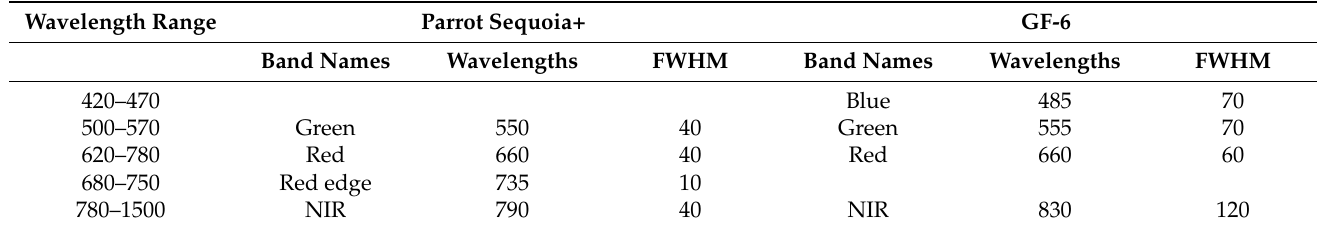
Table 5. Comparison of bands between GF-6 imagery and Parrot Sequoia+ multispectral UAV image. Wavelength Range Parrot Sequoia+